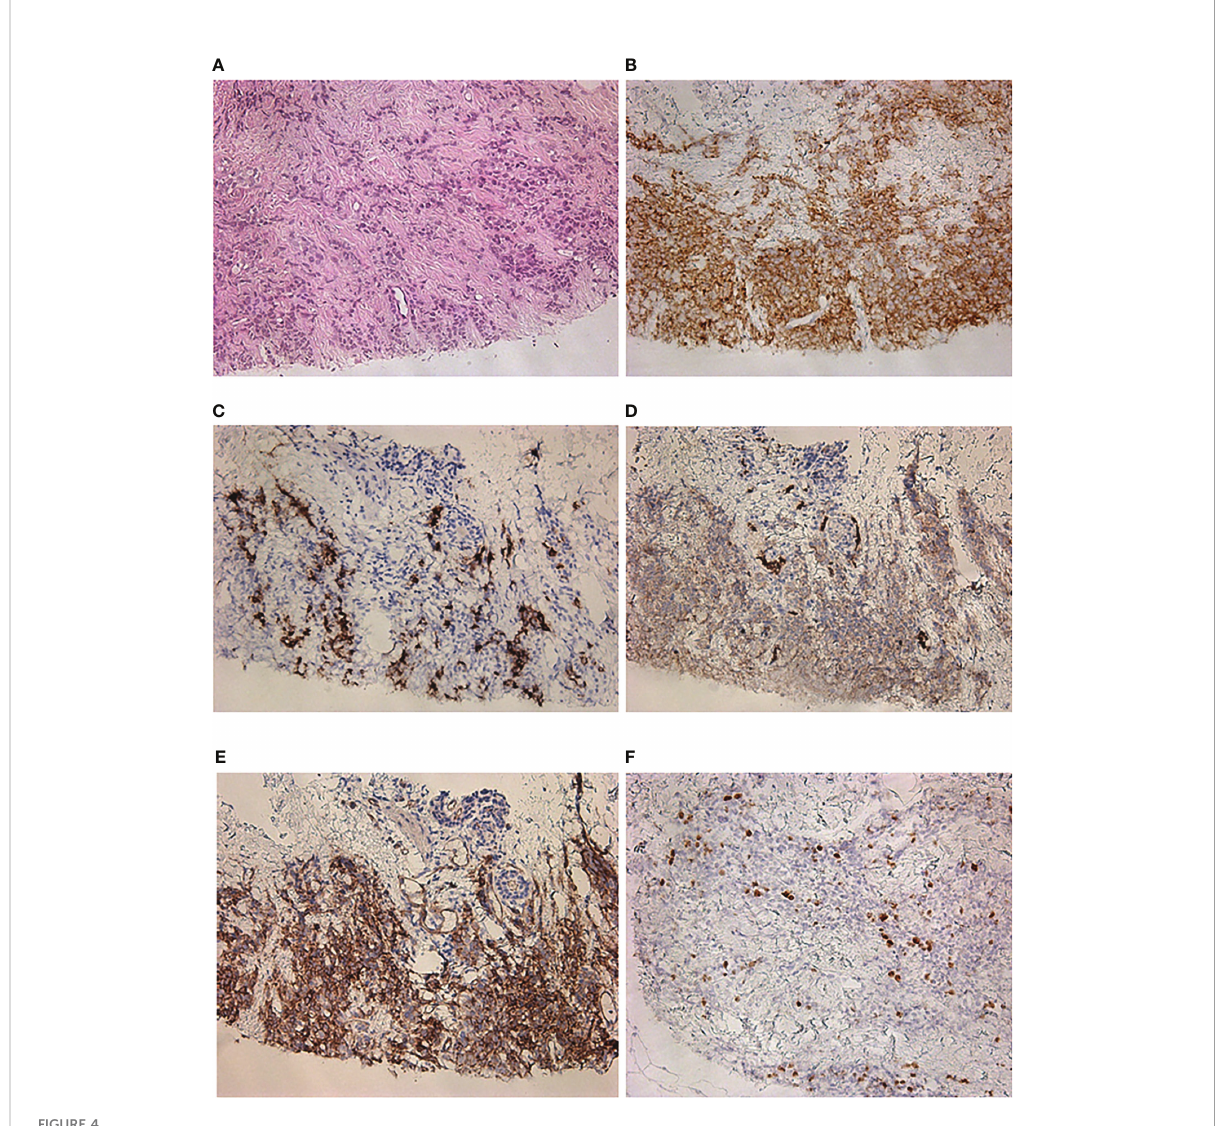
FIGURE 4 Histological and immunohistochemical examination of a metastatic lesion in the left breast. (A) Hematoxylin and eosin staining ×200. (B) Synaptophysin ×200. (C) ACTH ×200. (D) GLUT-1 ×200. (E) SSTR 5 subtype ×200. (F) Ki-67